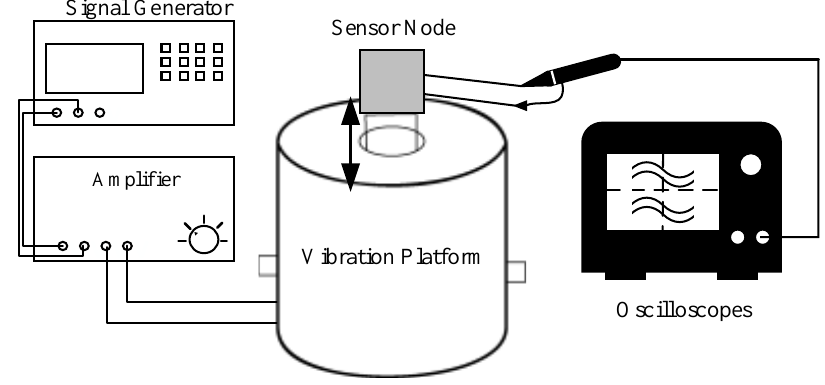
Figure 9. The experimental architecture of sensitivity test.